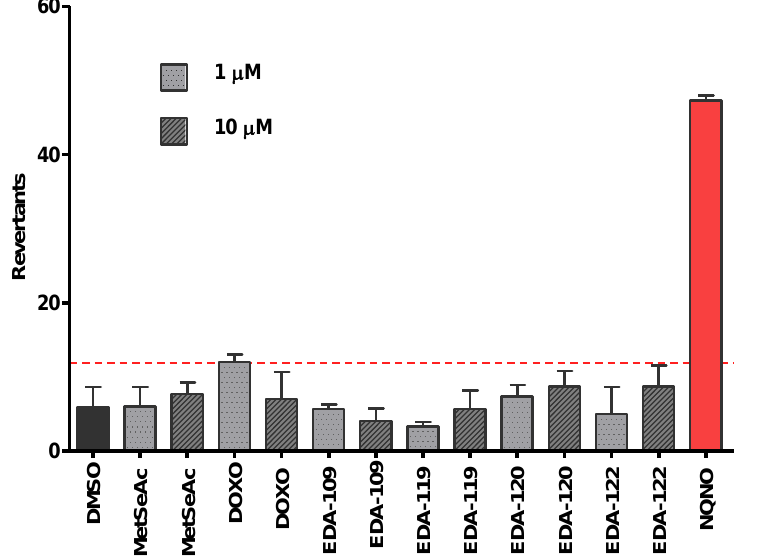
Figure 7. Safety profile (384-well microfluctuation Ames test) for the selenoesters with very high cytostatic activity, DMSO—solvent control. All tested compounds and references were evaluated at 1 and 10 µM concentrations, except for NQNO (0,5 µM); ---- baseline defining the mutagenicity threshold (over this line).